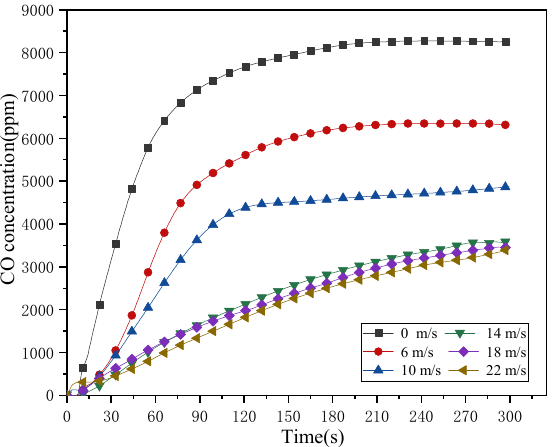
Figure 11. The CO concentration with air curtains installed on the two sides ( left ) and ( right ).